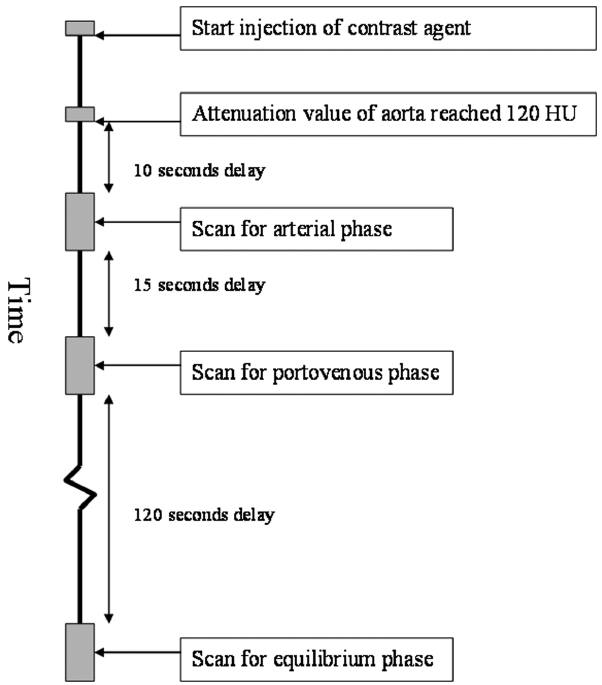
Figure 1. The imaging protocol for computed tomography dynamic study was